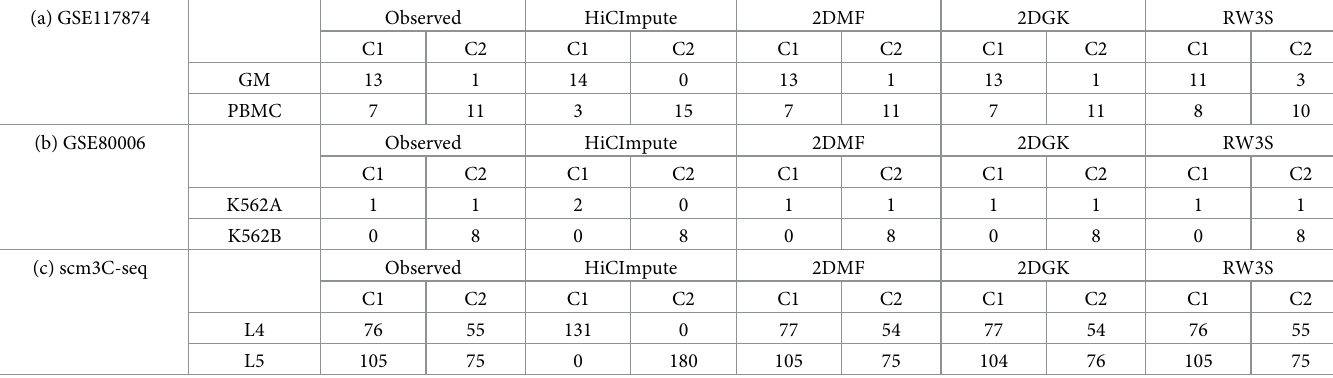
Table 2. Clustering results for three single cell Hi-C datasets before and after data improved with four methods. (a)